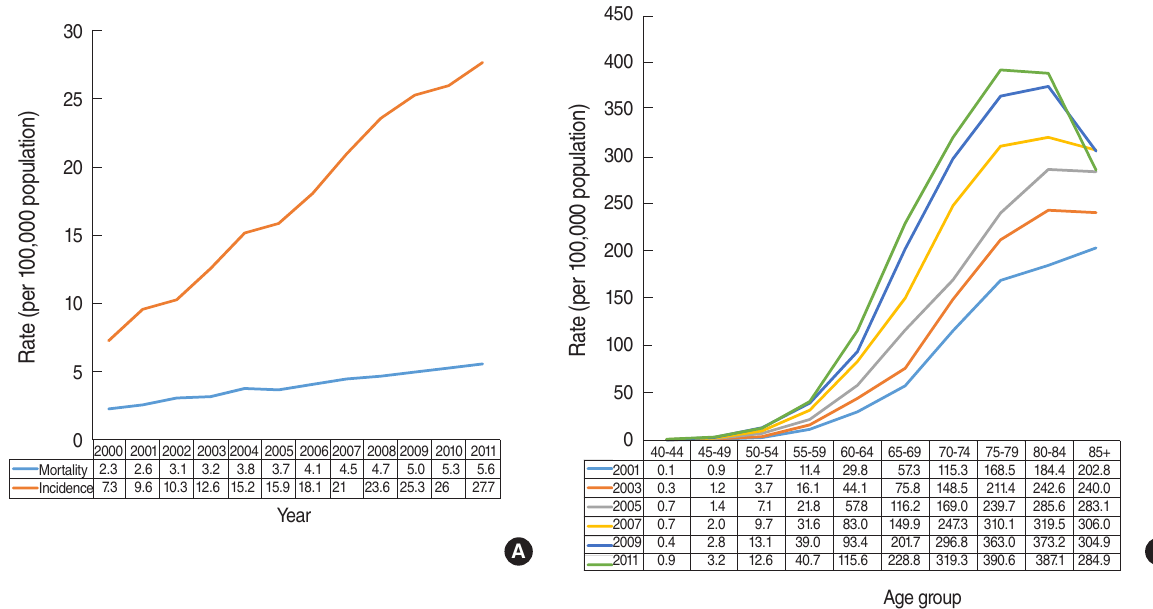
Figure 1. Prostate cancer in Korean men. (A) Age-adjusted incidence and mortality between 2000 and 2011. (B) Age-adjusted incidence in 2001, 2003, 2005, 2007, 2009, and 2011 by age group.